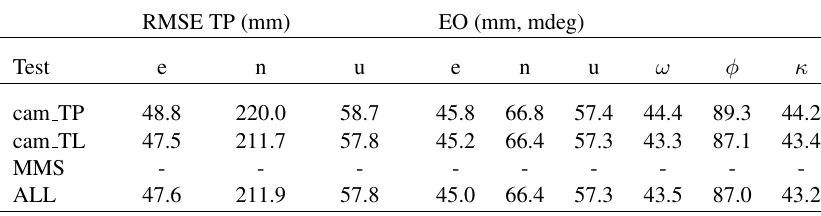
Table 7: Camera test results